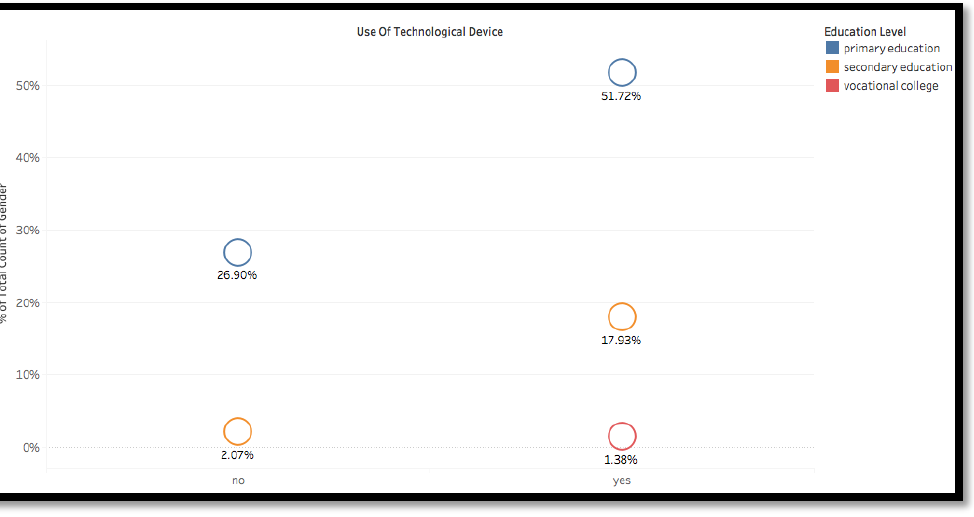
Figure 7. Use of technological devices for small holder farmers with education